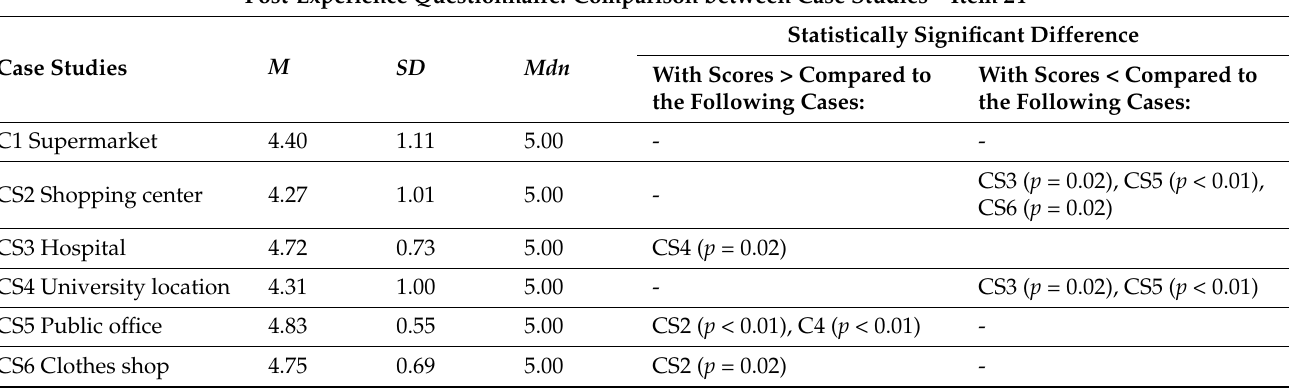
Table A26. Table shows the statistically significant differences ( p (BH)) that emerged from the comparison of item 24 in the different case studies (CS1–CS9). In the table is also reported the mean ( M ), the standard deviation ( SD ) and the median ( Mdn ). Own processing.